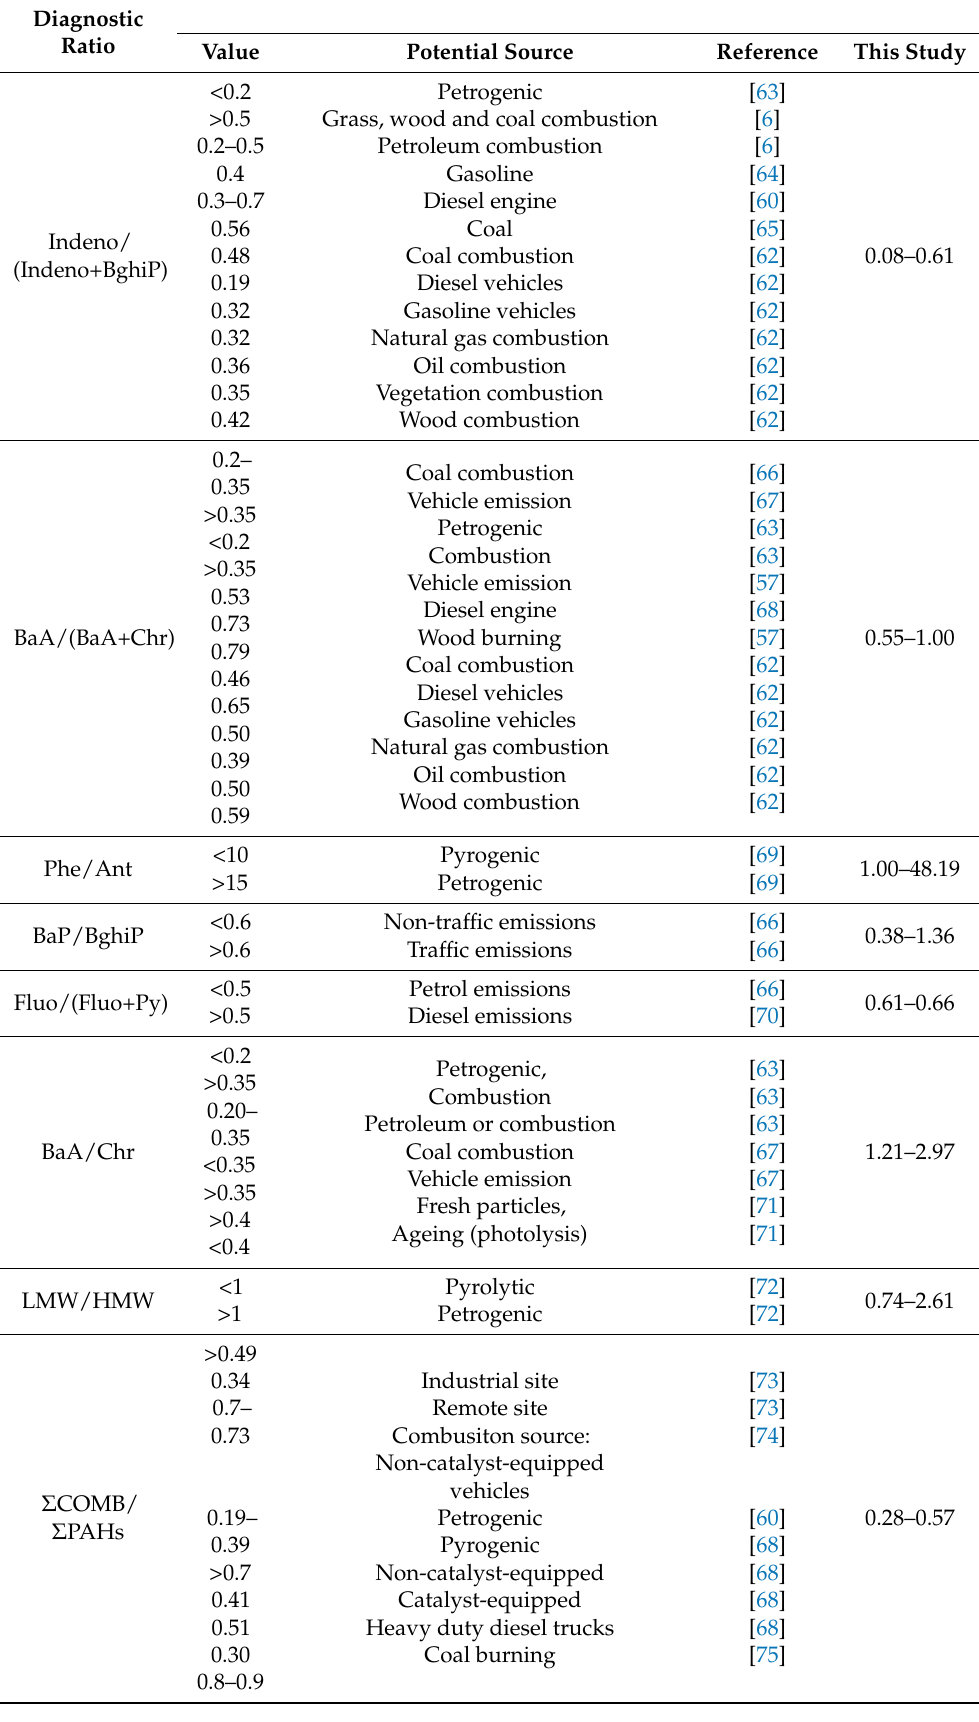
Table 5. Diagnostic ratios of atmospheric